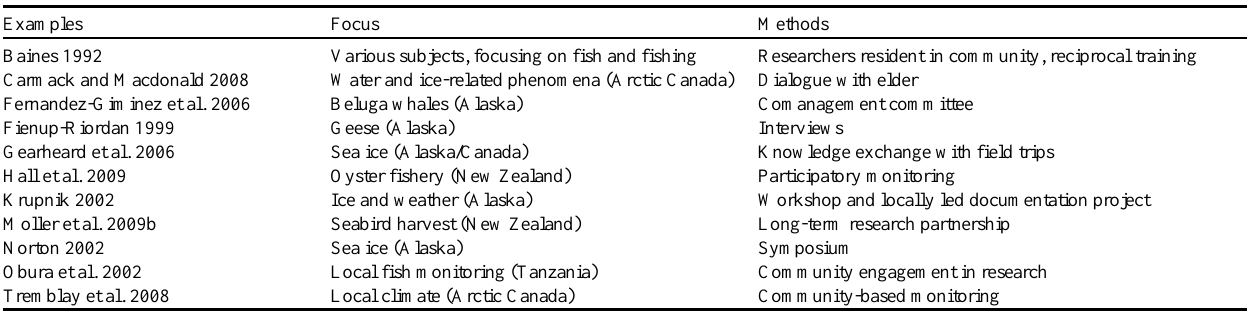
Table 4 . Collaborative projects that bridge LTK and science: examples from the